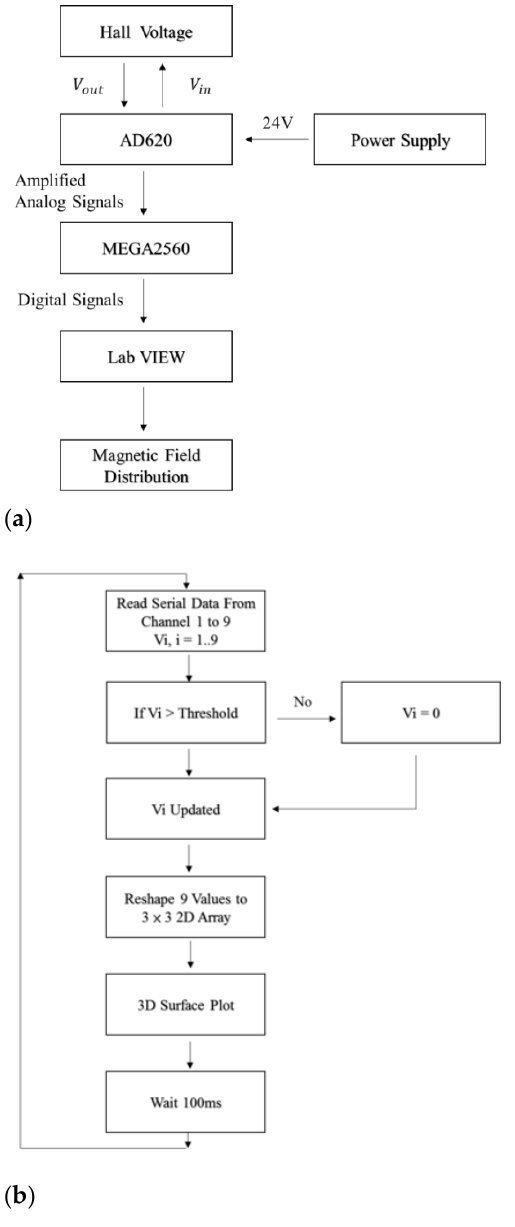
Figure 3. Block diagrams showing ( a ) analog circuit and signal conversion path of proposed Hall sensor array and ( b ) LabVIEW program of the visualization platform of the magnetic field map- ping.